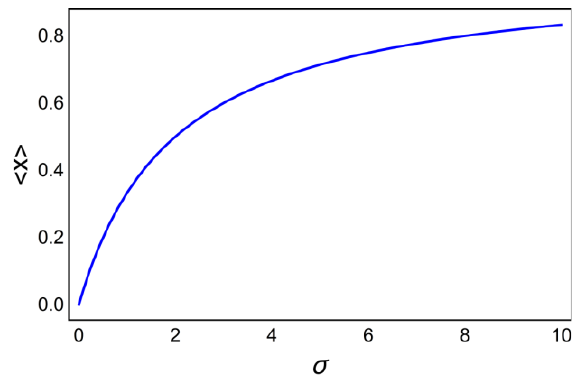
Figure 9. The cumulative activation as the function of the effective activation rate 𝜎 .